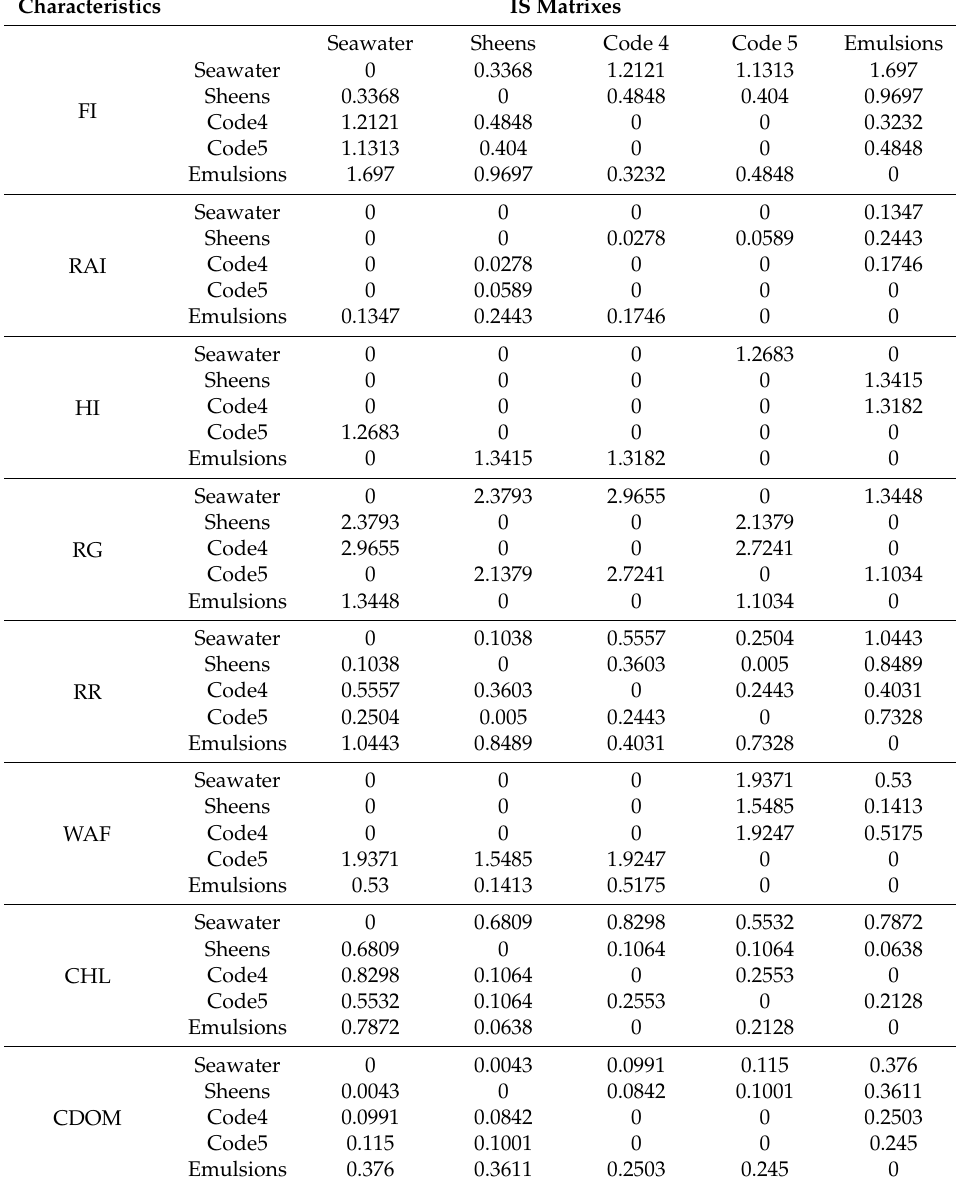
Table 3. Index separability (IS) values calculated by the training